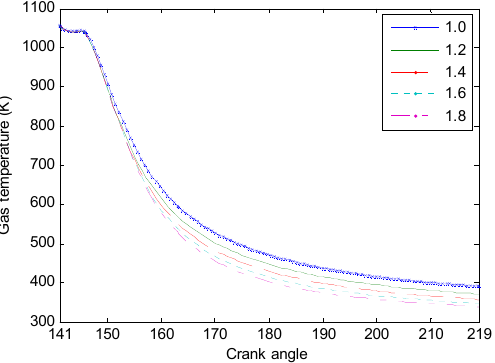
Figure 2. Simulation value of the gas temperature in the cylinder with different 𝜉 during the scavenging process